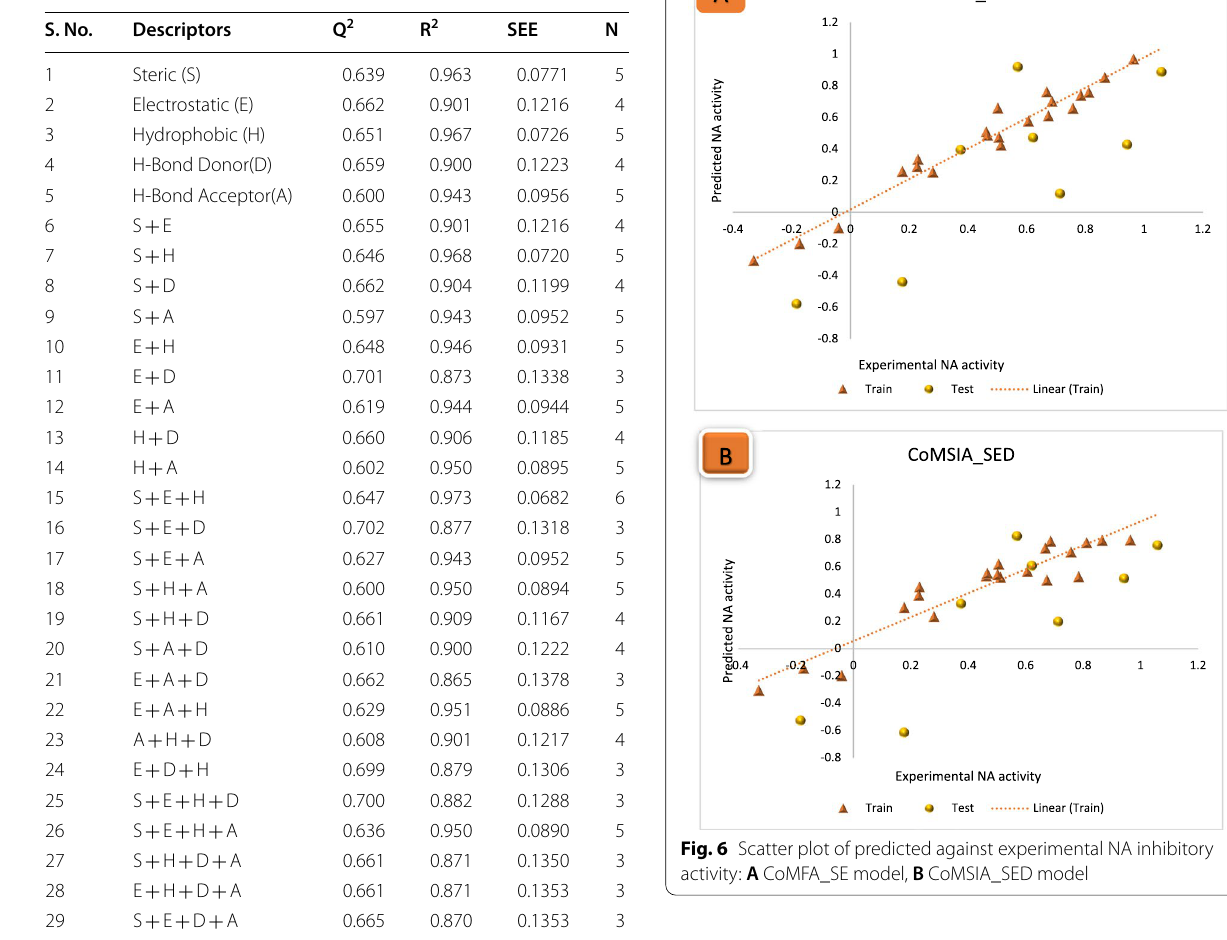
Table 10 Statistical validation results of all possible CoMSIA models